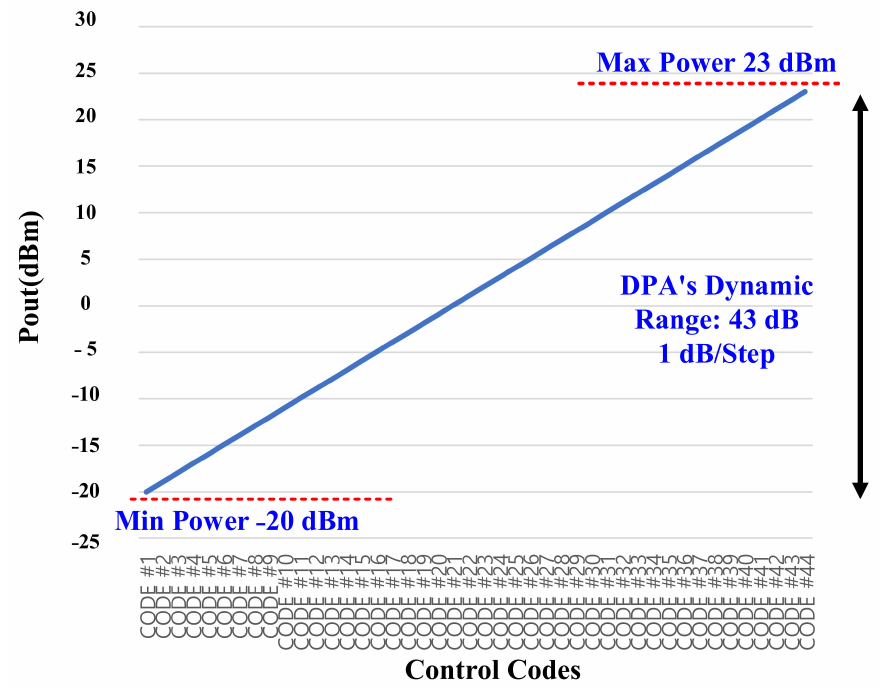
Figure 15. The measured gain steps and dynamic range for the low band (the results are standardized for the application using the 0.5 dB fine-gain adjustability and reducing the maximum power from 27 dBm to 23 dBm).